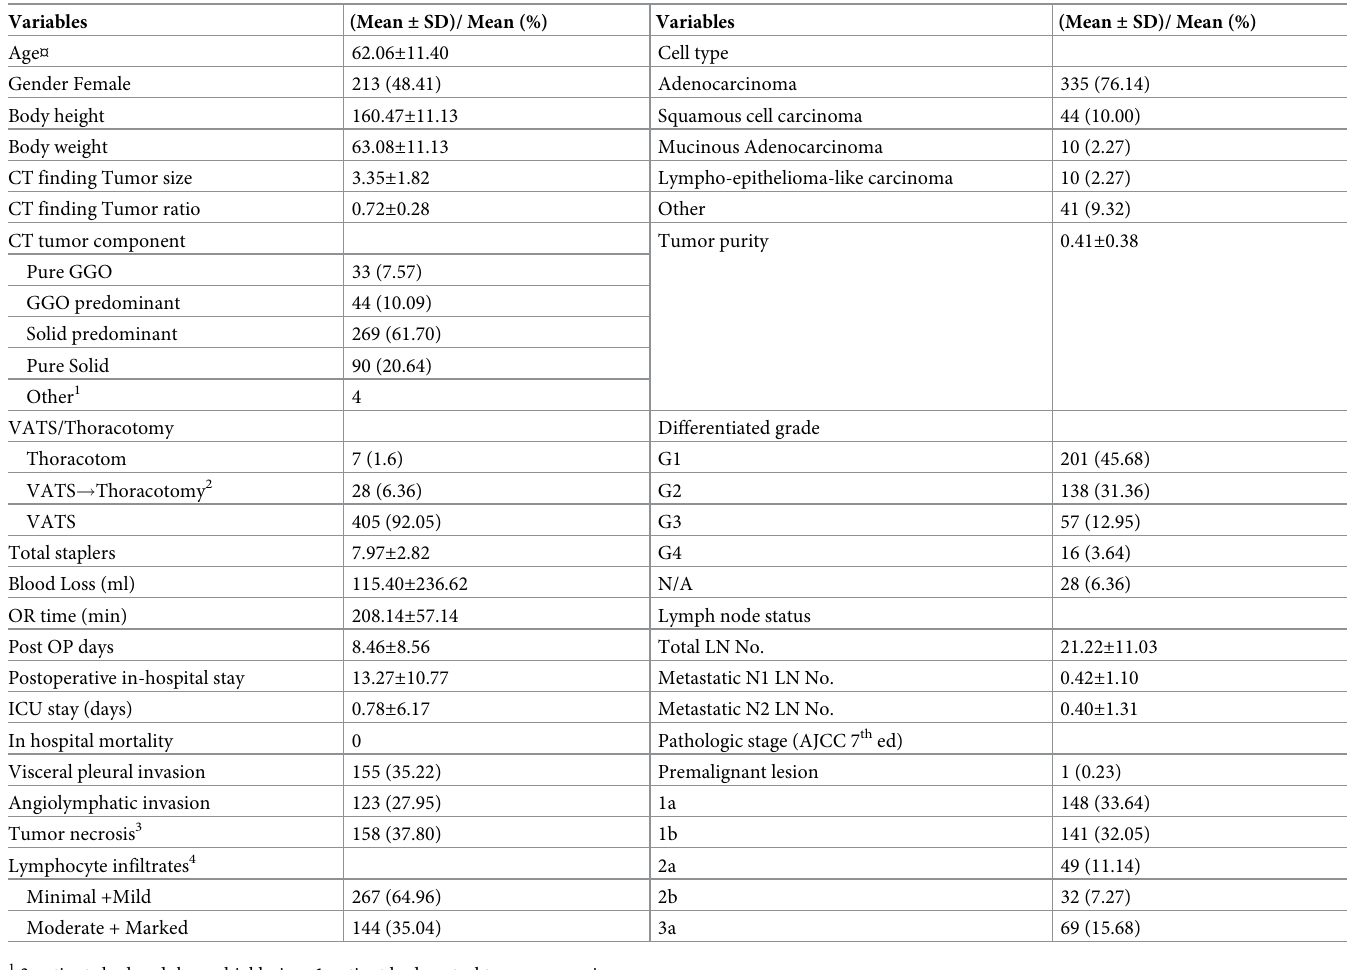
Table 1. Descriptive data for non small cell lung cancer patients who received anatomic